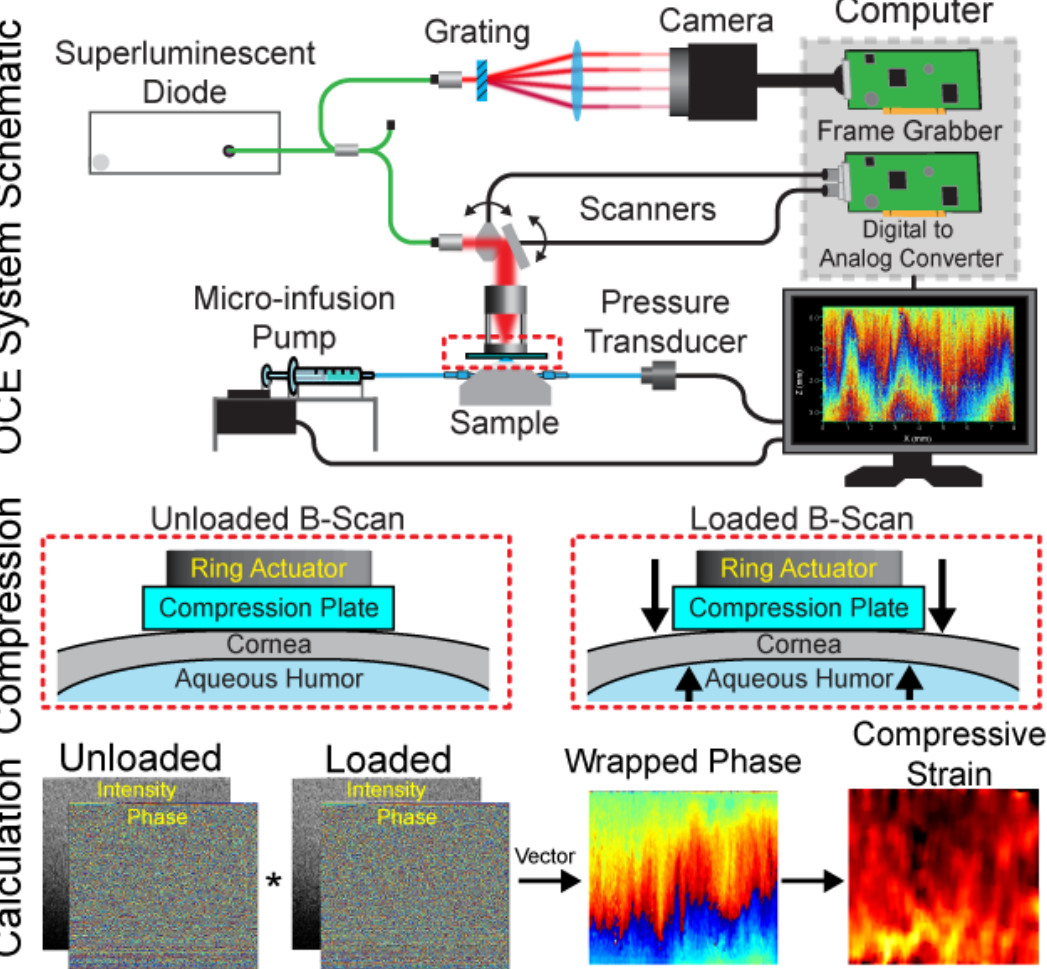
Figure 1. Optical coherence elastography (OCE) imaging and data processing paradigm. ( top ) Schematic of the OCE system during in situ imaging of the rabbit corneas. ( middle ) Compression OCE imaging paradigm. ( bottom ) Strain mapping calculation steps. * denotes complex conjugate multiplication.